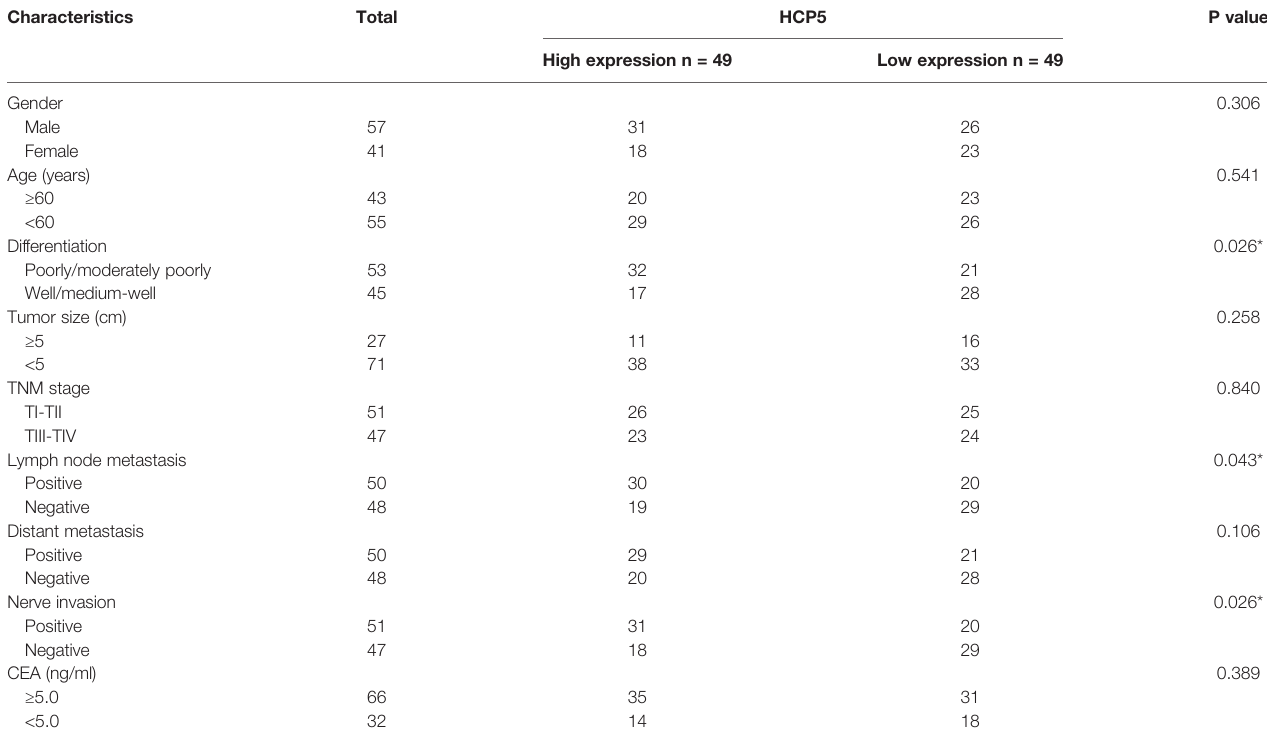
TABLE 3 | The Correlation between HCP5 expression and clinicopathologic parameters of GC patients.